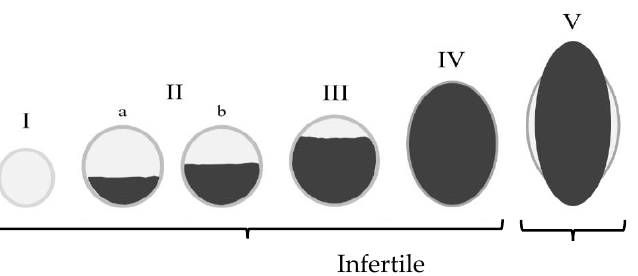
Figure 1. Christopher stages of egg development. Mosquitos whose eggs have fully developed to stage V (normal elongated, boat/sausage-shaped eggs with lateral floats) are classified as ‘fecund’ or ‘fertile’. If eggs have not fully developed and remain in stages I–IV (less elongated, round shape, lacking floats), the mosquito is classified as ‘non-fecund’ or ‘infertile’ .